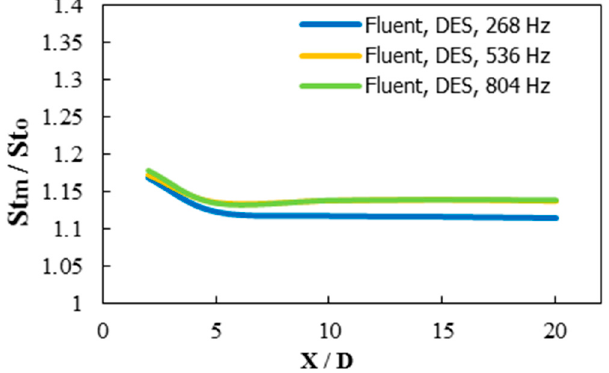
Figure 27. The centerline Stanton number ratio obtained using the DES Realizable k - ε model for M = 0.5 for the 268, 536, and 804 Hz oscillations.